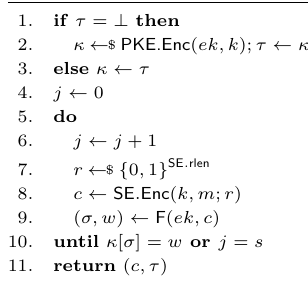
Figure 10: Our type 2 asymmetric ASA on symmetric